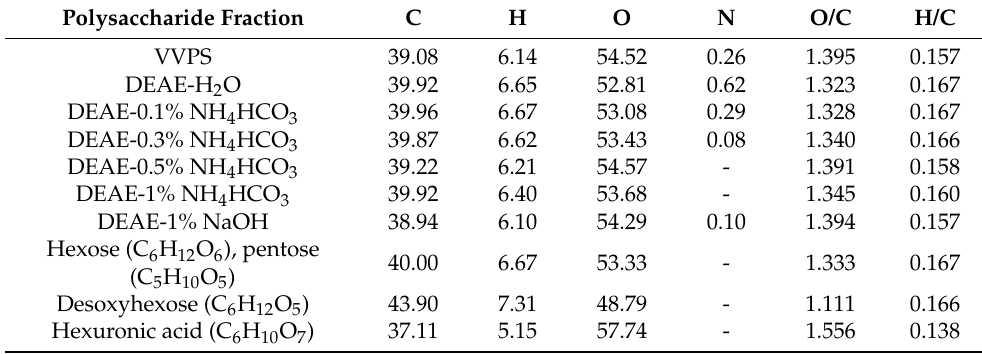
Table 2. Elemental composition and O/C, H/C ratio of VVPS and DEAE–cellulose fractions, %. Polysaccharide